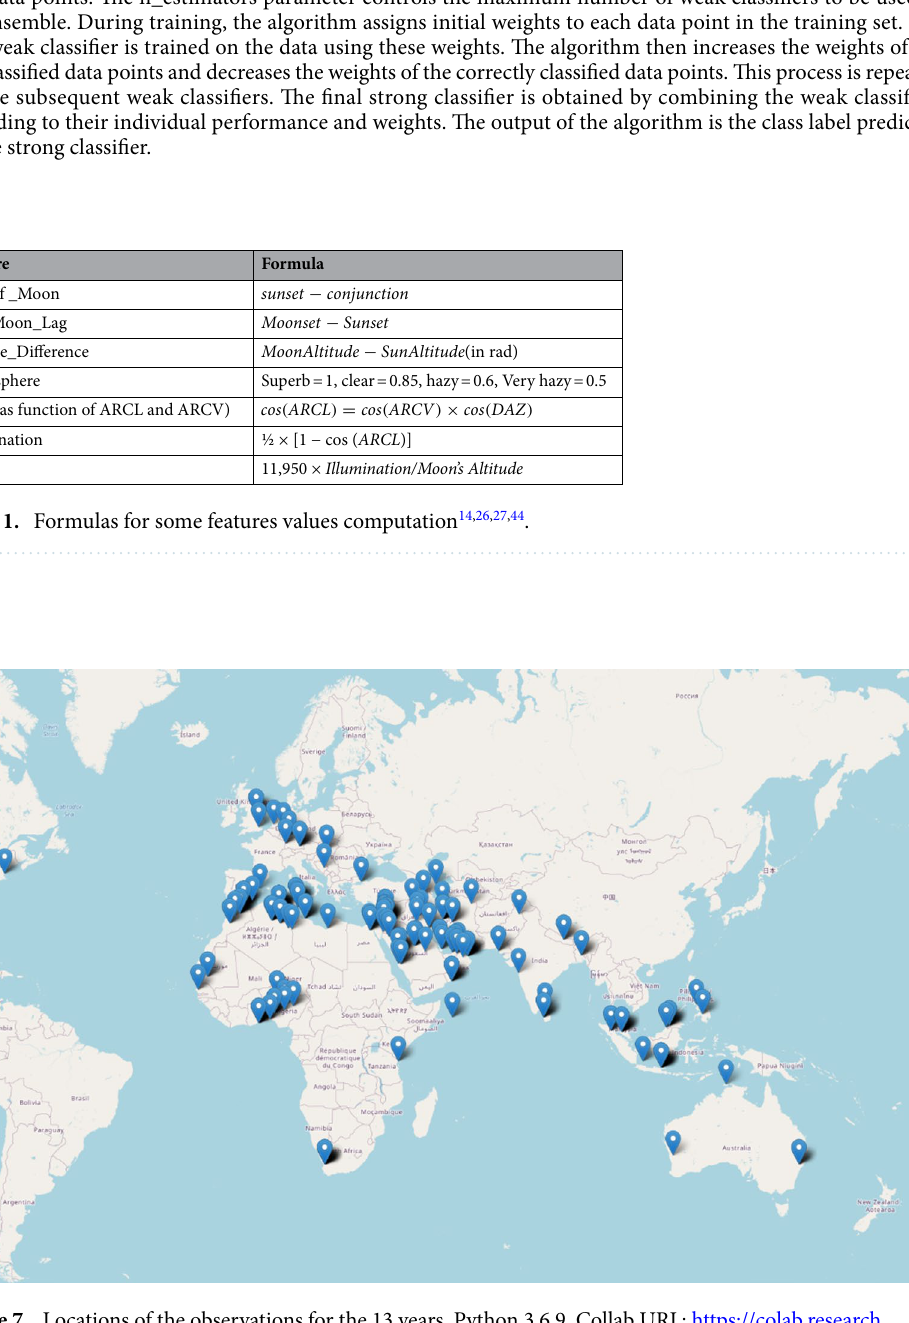
Figure 7. Locations of the observations for the 13 years. Python 3.6.9, Collab URL: https:// colab. resea rch. google.